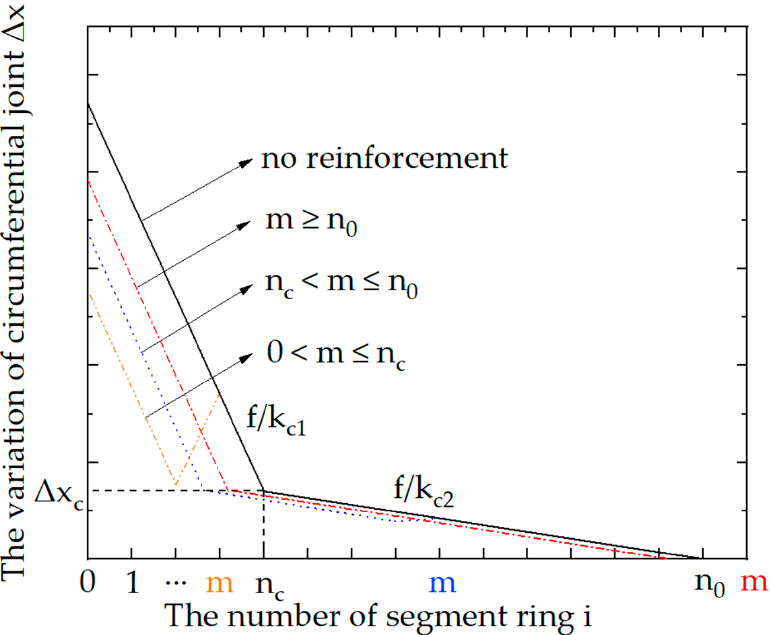
Figure 6. Relationship curves of circumferential joint variation with different segment rings in different reinforcement